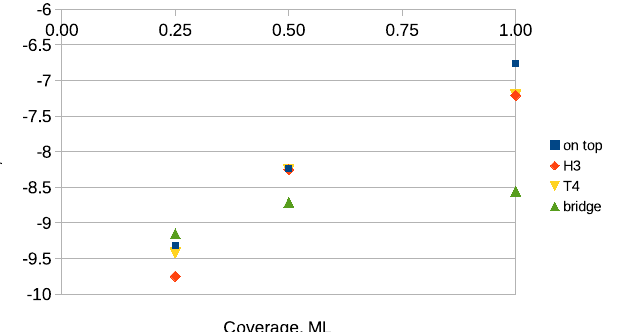
Figure 8. Adsorption energies vs. coverage on the N-terminated surface. Starting adsorption sites are shown in the legend